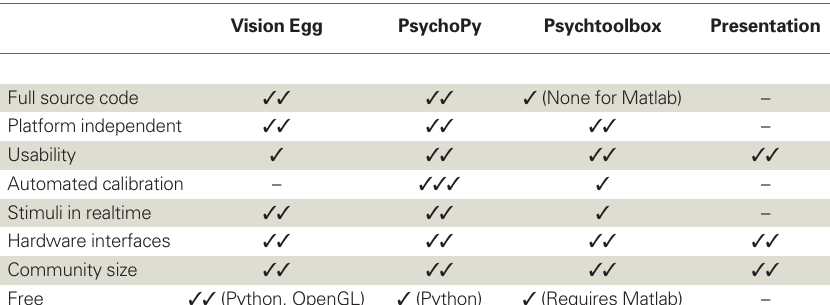
Table 1 | Comparison of several frequently used software packages for visual stimulus